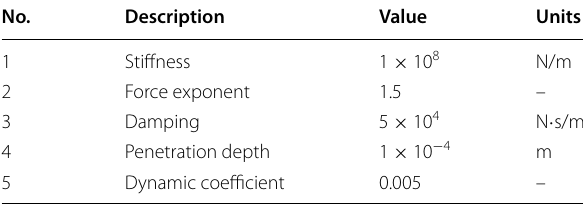
Table 3 Setting of contact parameters